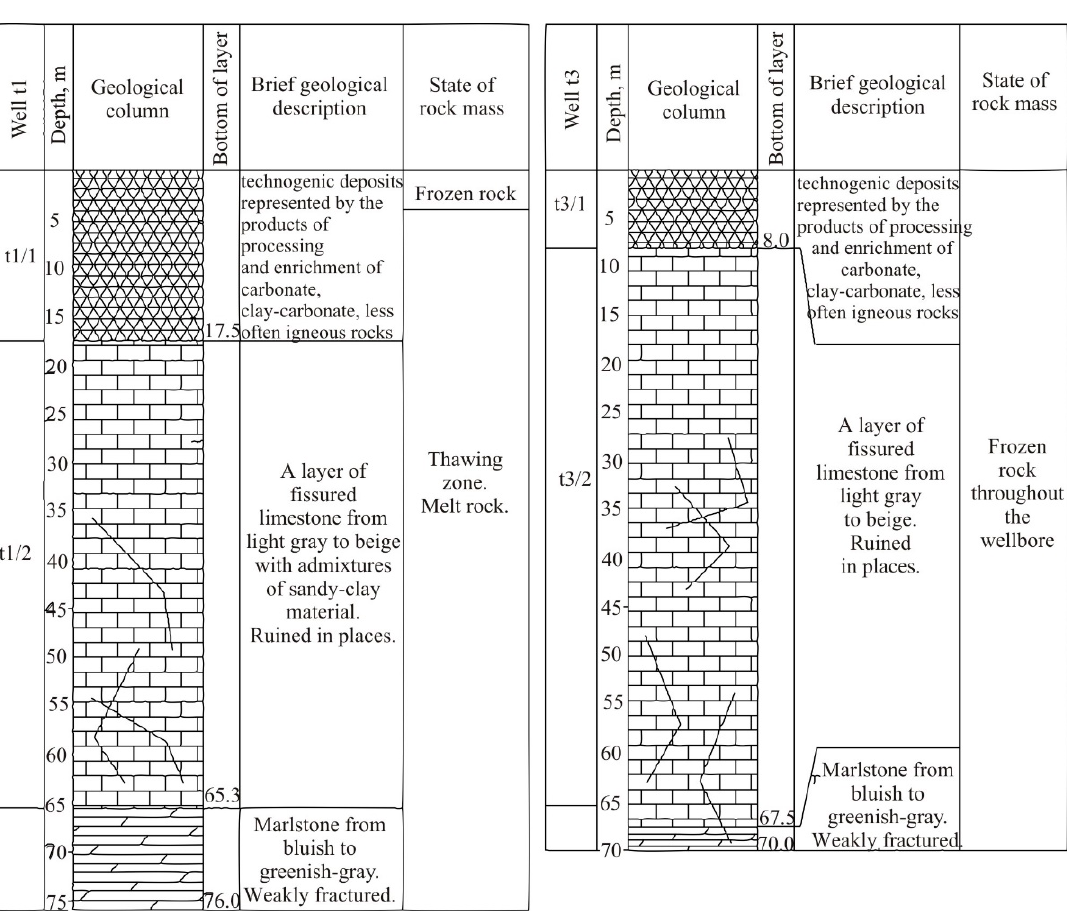
Figure 5. The structure of wells t1 and t3, adopted for numerical modeling of thawing by circulating water. Table 1. Thermophysical characteristics of the wells’ units adopted for physical modeling.